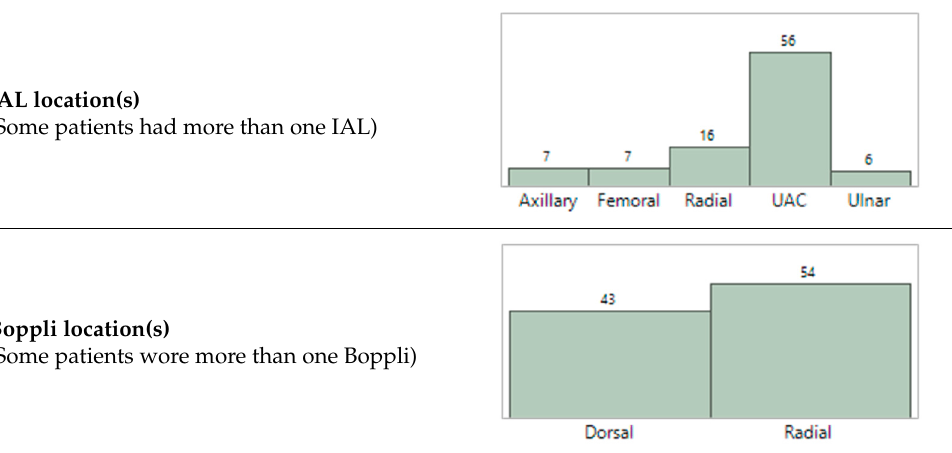
Table 5. Characteristics of the IAL and Boppli placement locations.